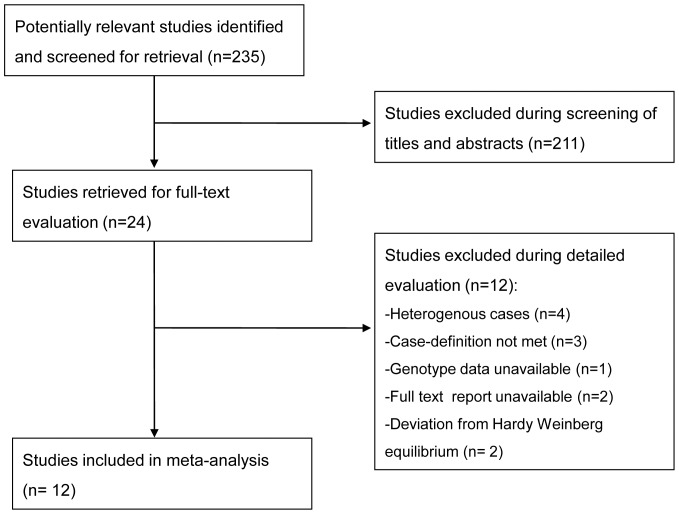
Study flow through the selection process.